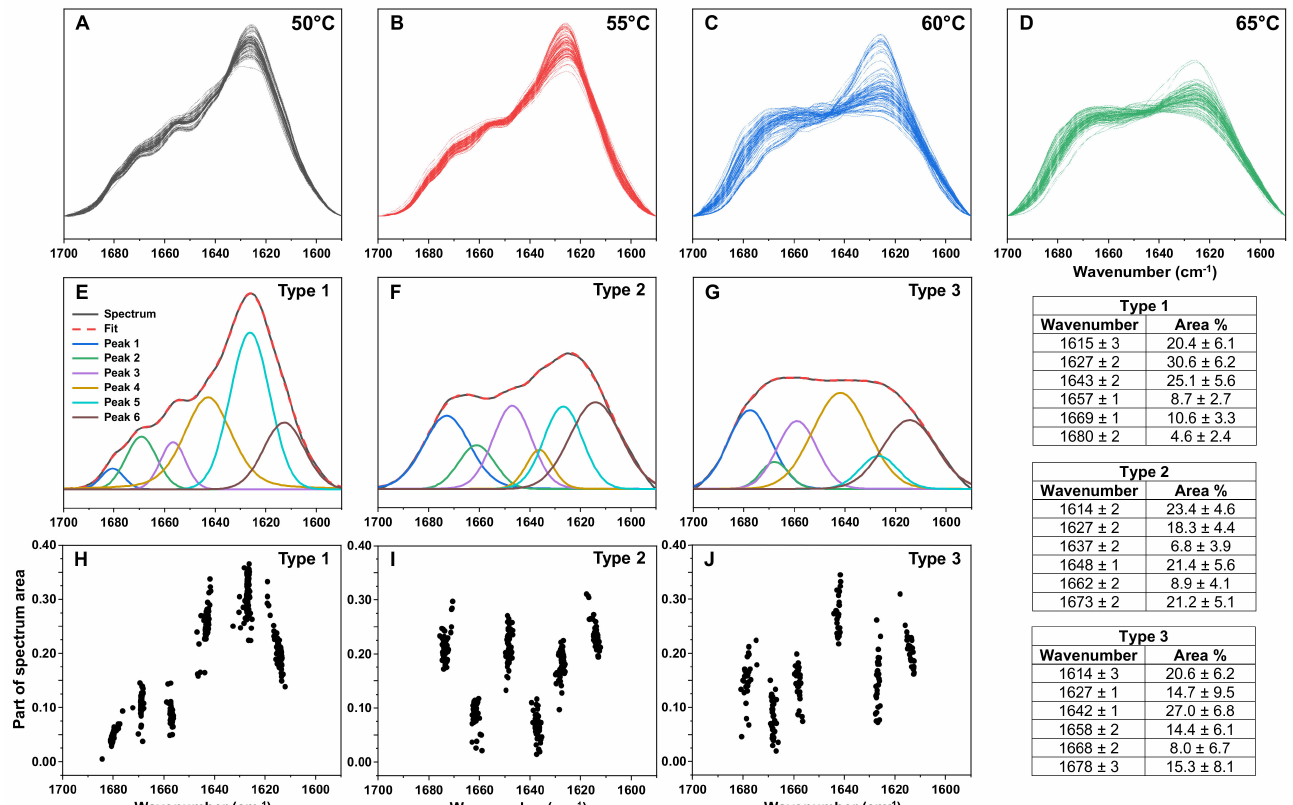
Figure 3. Fourier-transform infrared (FTIR) spectra of lysozyme aggregates prepared under different temperature conditions. Spectra of lysozyme aggregates prepared at 50 ◦ C ( A ), 55 ◦ C ( B ), 60 ◦ C ( C ) and 65 ◦ C ( D ), with all sample ( n = 96) spectra superimposed and colour-coded. Peak-fit of Type 1 ( E ), Type 2 ( F ) and Type 3 ( G ) aggregate spectra and peak position/area distributions ( H – J ). The peak- fitting procedure was performed on 50 ◦ C and 65 ◦ C condition spectra. Table inserts display the peak positions and areas of all three aggregate-type FTIR spectra. Raw data are available in the Supplementary